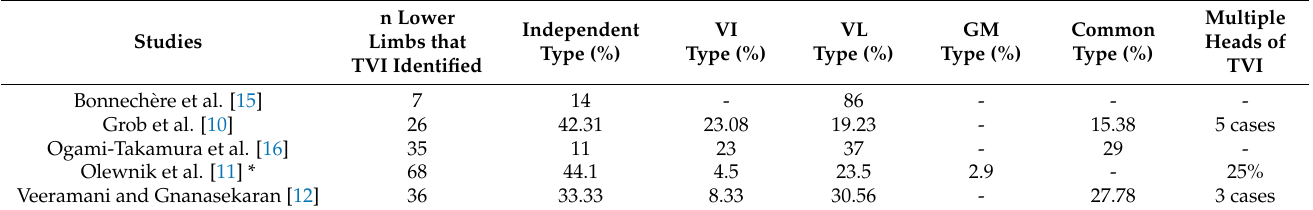
Table 3. Prevalence of tensor of vastus intermedius variations between anatomical studies.